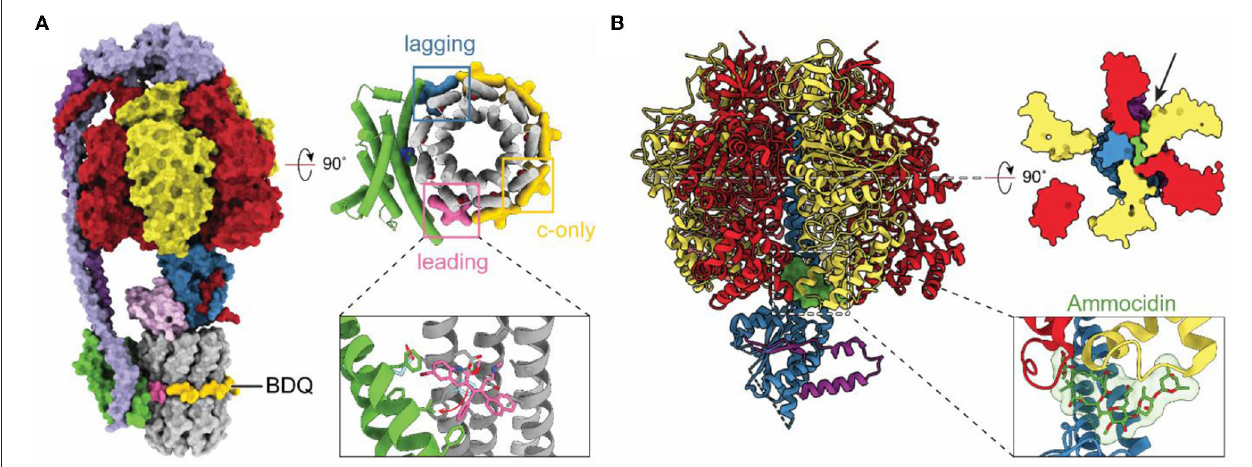
FIGURE 5 | Structures of drug-bound ATP synthases. (A) Atomic model of M. smegmatis ATP synthase bound to the tuberculosis (TB) drug bedaquiline (BDQ) (PDB: 7JGC) ( Guo et al., 2021). Bedaquiline binds at five c-only sites (yellow), a leading site (pink), and a lagging site (blue) in the F O region of the enzyme. Red arrows indicate the movement of residues upon bedaquiline binding. (B) Atomic model of S. cerevisiae ATP synthase F 1 region bound to Ammocidin (PDB: 7MD2) (Reisman et al., 2021 ). Ammocidin (green) binds at the rotor–stator interface (black